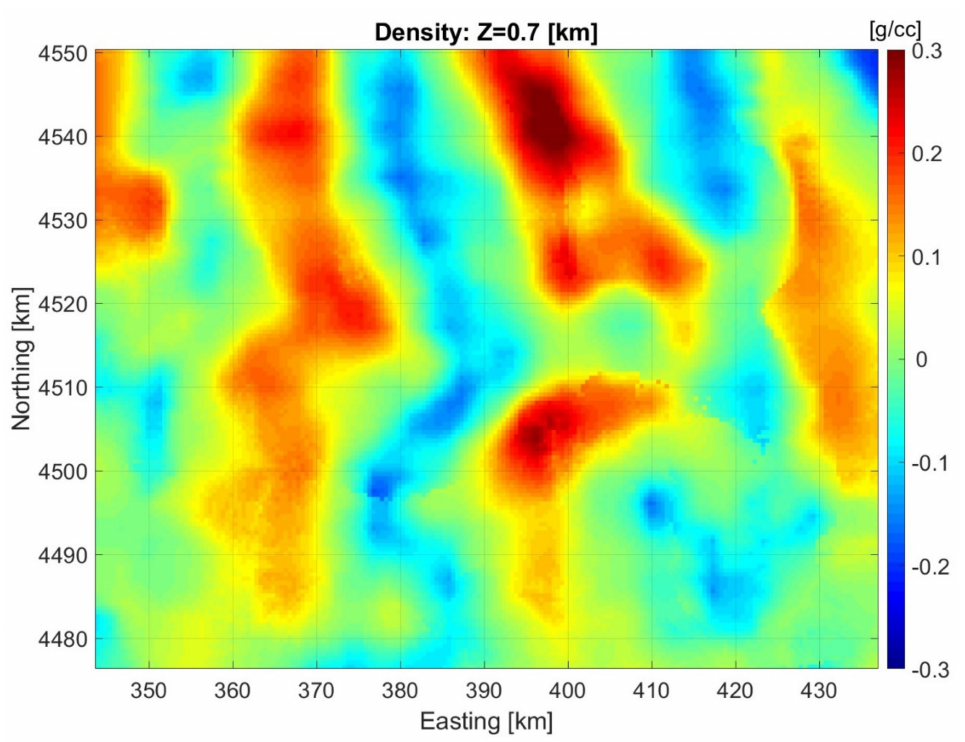
Figure 14. Horizontal section of the density inverse model produced by the inversion with a priori density contrast model at elevation 0.7 km model above sea level.